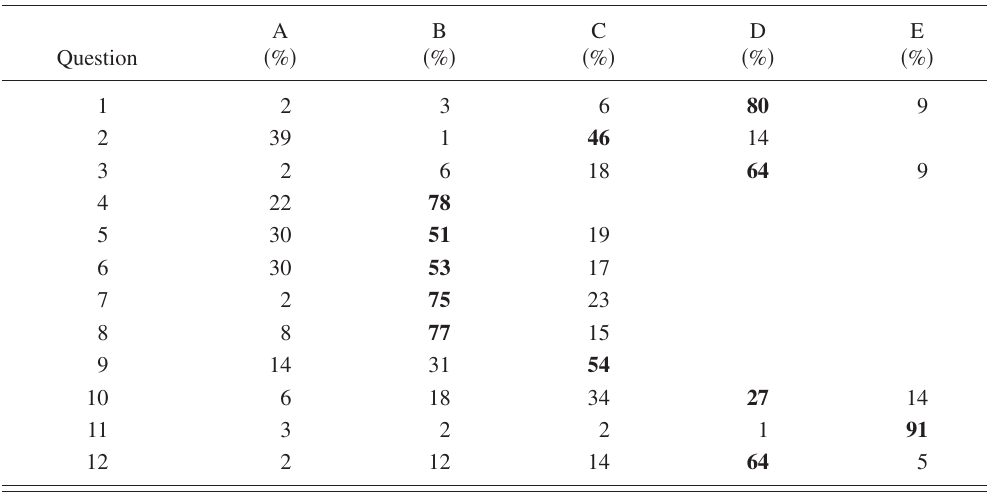
TABLE IV. Modern physics students’ posttest responses to each question in Version 2.0. Correct answers are in bold.